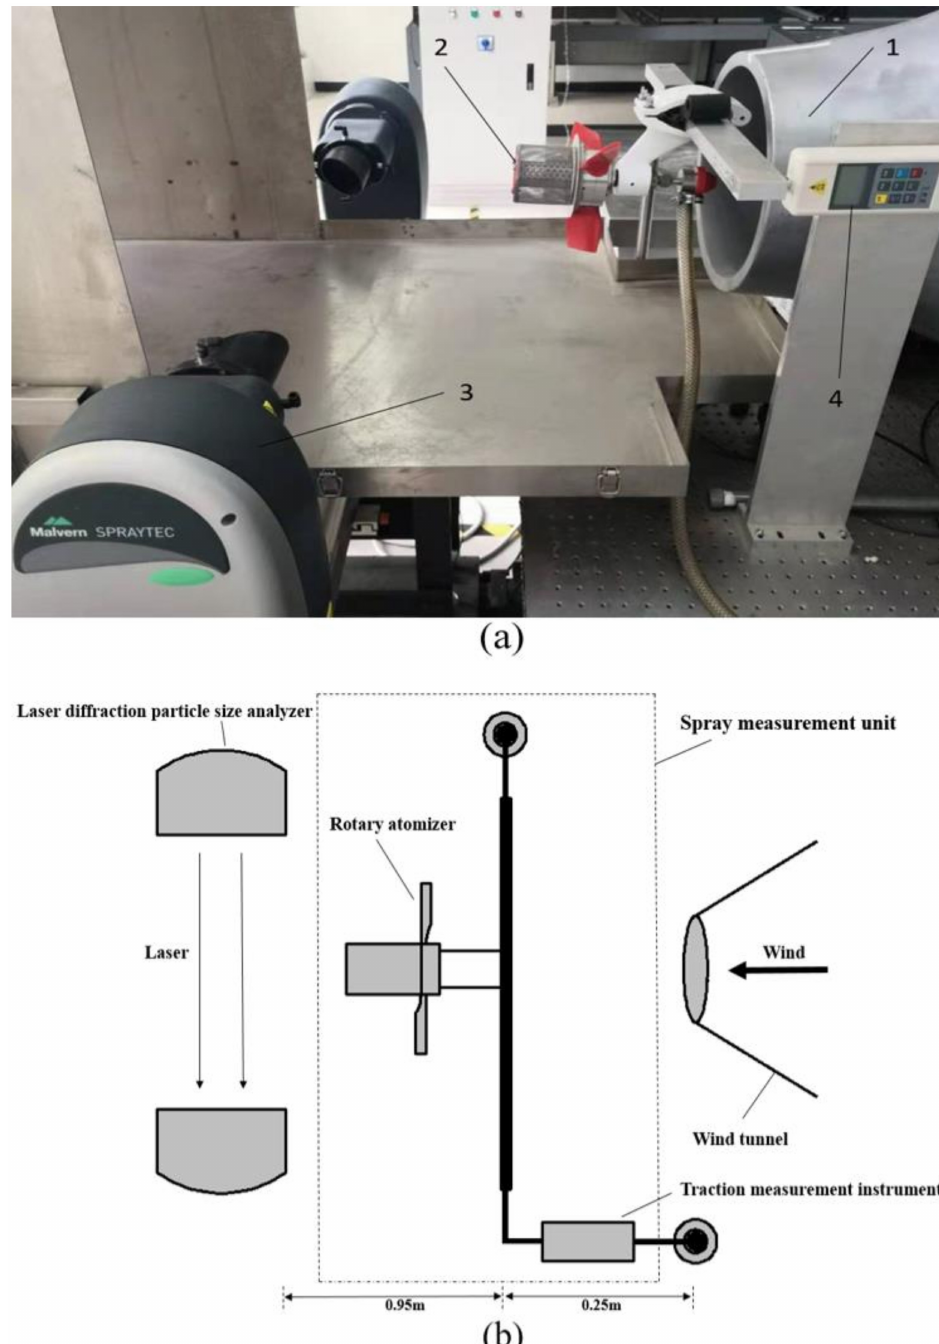
Figure 1. ( a ) Photograph and ( b ) schematic diagram of an AU5000 wind tunnel atomization test platform. The following parts are shown: 1, wind tunnel; 2, AU5000 rotary atomizer; 3, Malvern Spraytec LD; 4, traction measurement